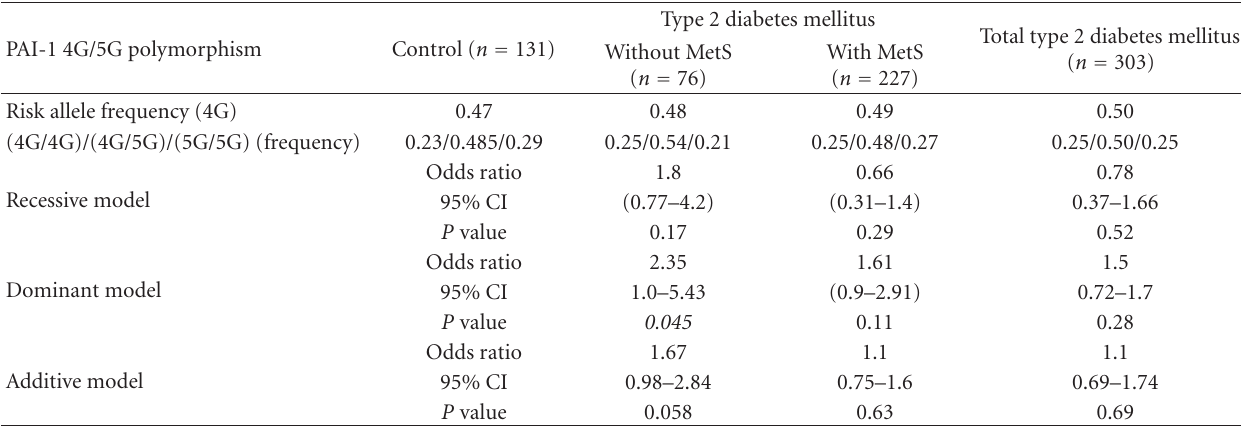
Table 2: Association of PAI-1 4G/5G polymorphisms with type 2 diabetes mellitus in Malaysian